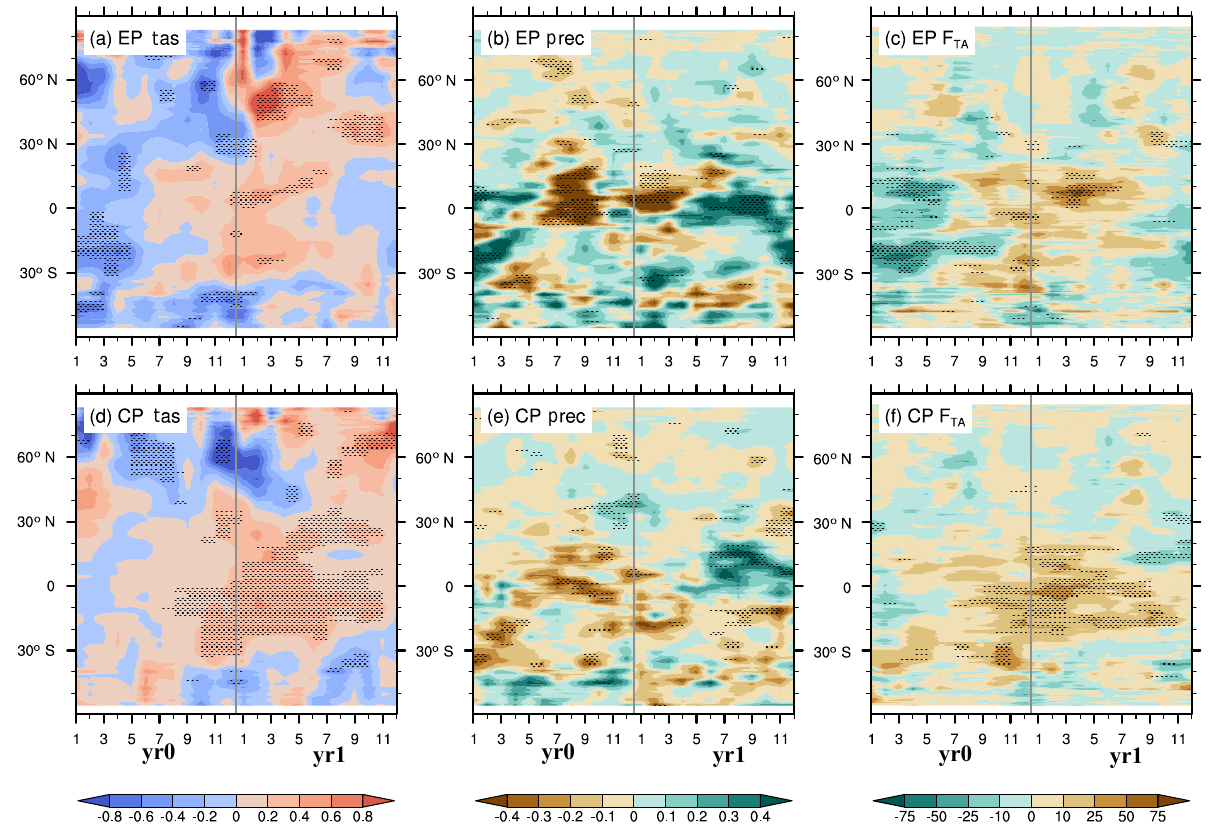
Figure 6. Hovmöller diagrams of the anomalies in climate variables and the F TA (averaged from 180 ◦ W to 180 ◦ E) during EP and CP El Niño events. Panels ( a and d ) show surface air temperature anomalies over land (units: K); panels ( b and e ) show precipitation anomalies over land (units: mmd − 1 ); panels ( c and f ) show TRENDY-simulated F TA anomalies (units: gCm − 2 yr − 1 ) during EP and CP El Niño events. The dotted areas indicate the significance above the 80% level as estimated using the Student’s t